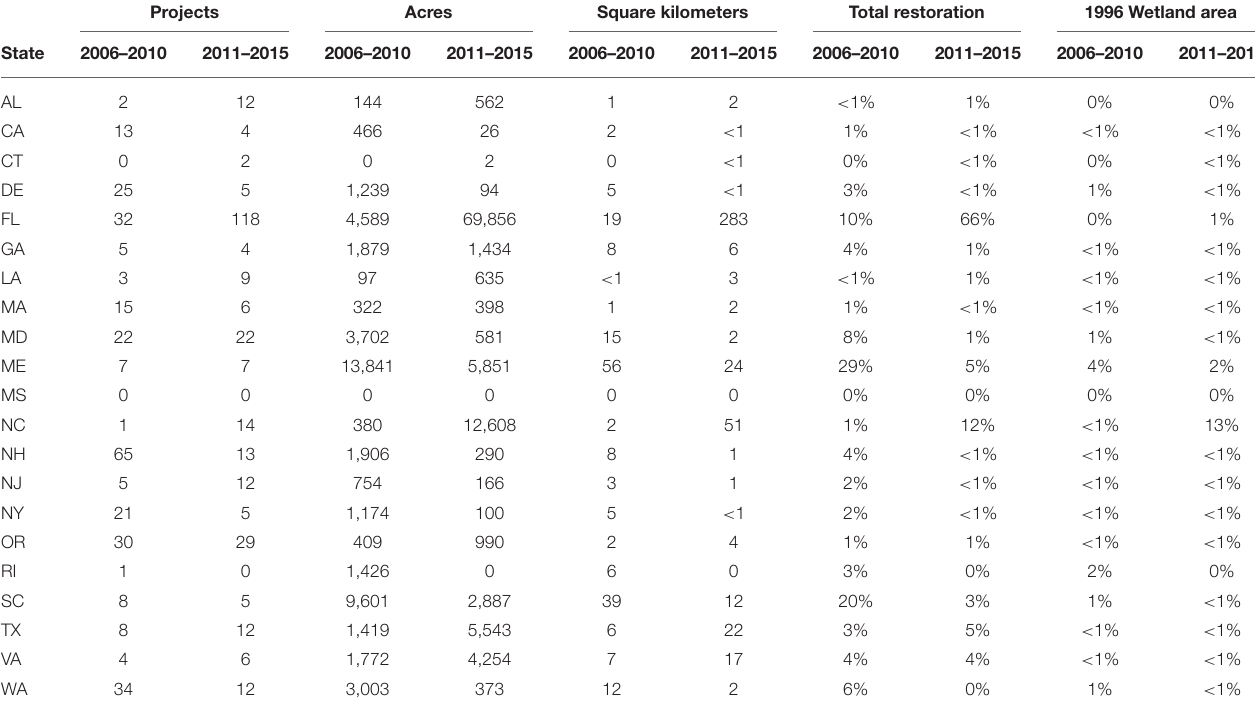
TABLE 4 | Voluntary palustrine restoration efforts from 2006 to 2015. Projects Acres Square kilometers Total